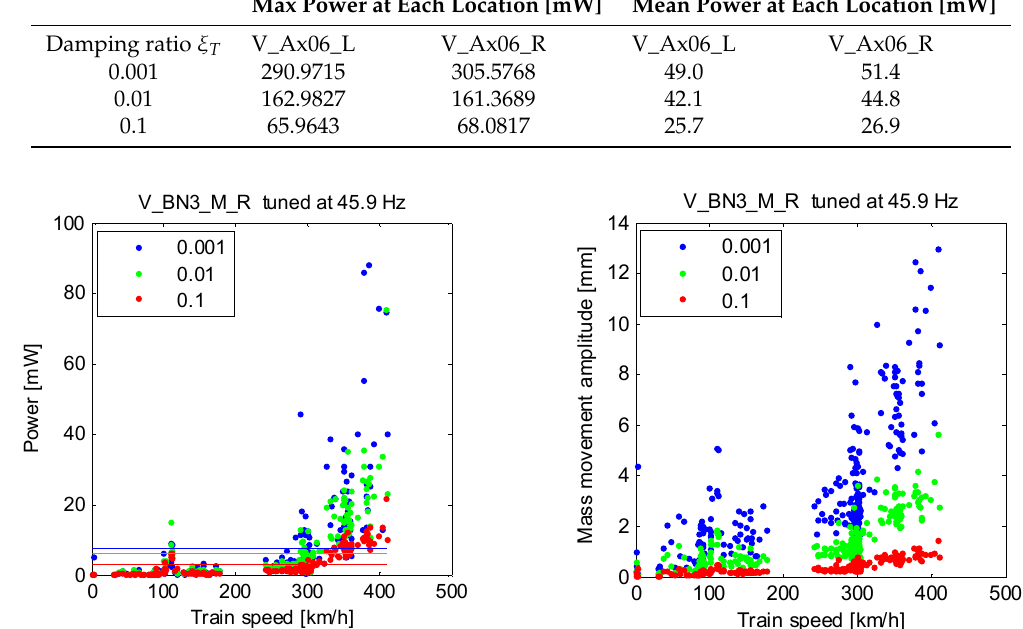
Figure 13. The estimated power generation and the relative vibration amplitudes of the harvester mass from the vertical vibration of the bogie when the total damping ratio is 0.001, 0.01, or 0.1; the mass is 0.1 kg; and the natural frequency is 45.9 Hz. The horizontal lines are the mean values for speeds above 100 km/h (at the vertical direction of the right side of the number 3 bogie, which is in the middle position (center) of each coach car: V_BN3_M_R).